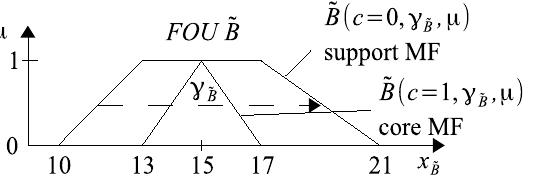
) on surface M × X , x ˜ B B